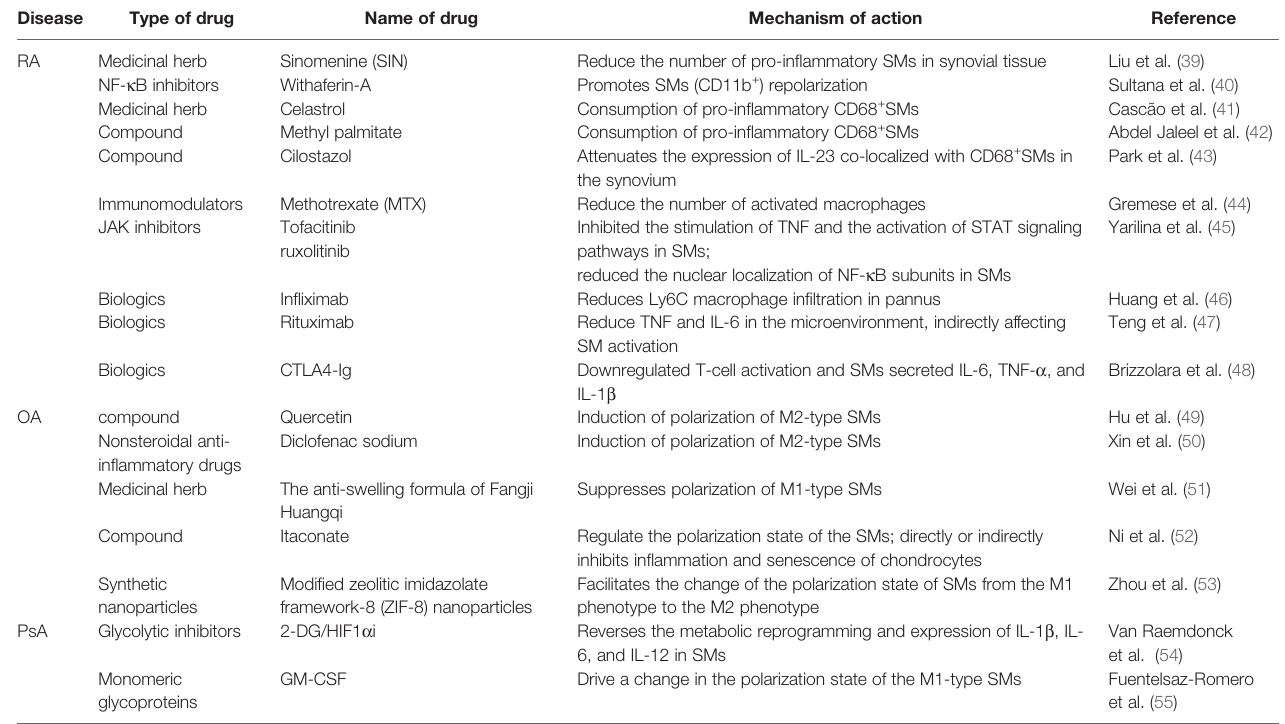
TABLE 3 | Commonly used drugs for the treatment of in fl ammatory arthritis by